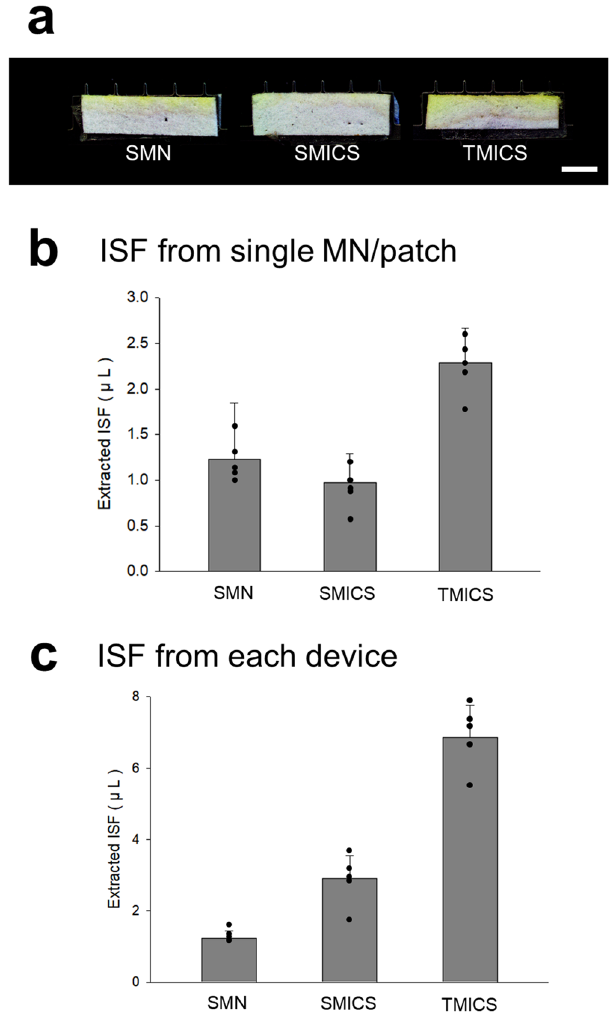
Figure 4. ISF collecting using the MN devices from a porcine skin ex vivo. ( a ) Digital image of the MN devices, SMN, SMICS, and TMICS, after collecting skin ISF. ( b ) Extracted skin ISF from a single MN patch (both side) of the MN devices. ( c ) Total extracted ISF from the MN devices. Graphs present average ± standard deviation based on 5 replicate samples (one-way ANOVA, p < 1.7 × 10 –5